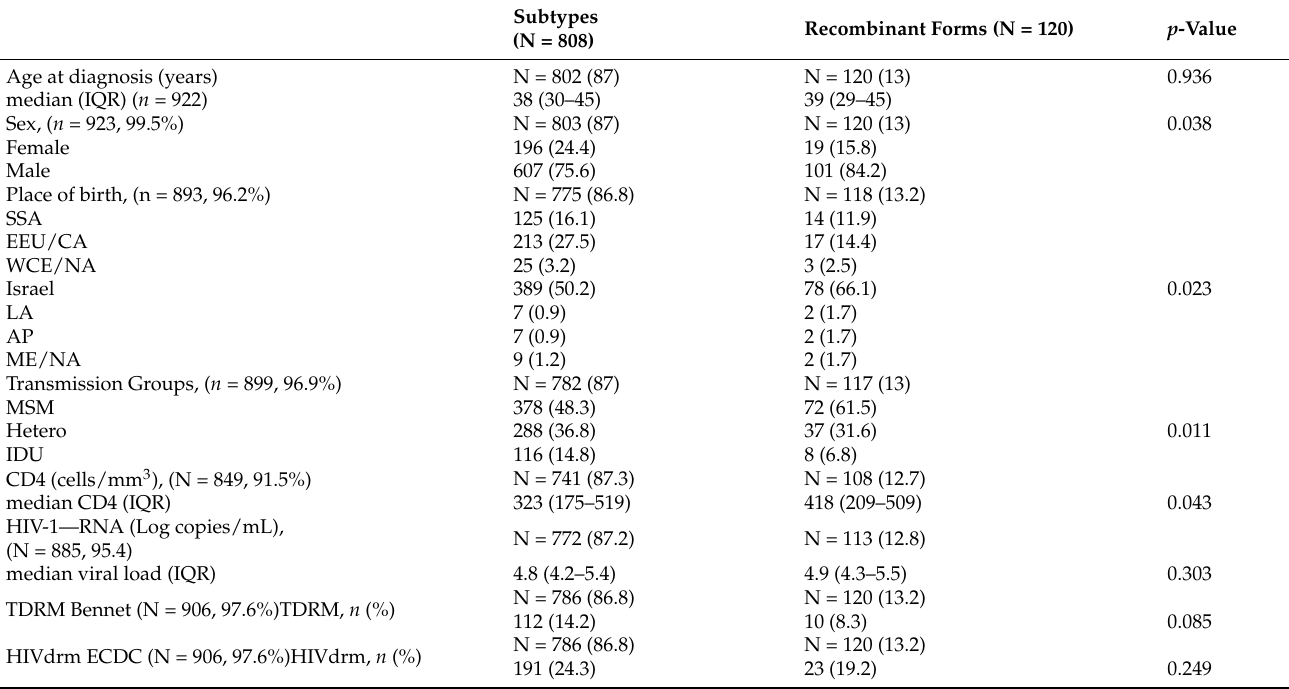
Table 2. Comparison of PLHIV diagnosed in 2010–2018 infected with A, B, and C subtypes to those with CRFs and URFs (recombinant forms).